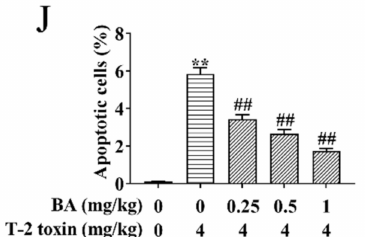
Figure 4. Effects of BA on spleen injury in T-2 toxin-exposed mice. Morphological changes in the spleen were examined using hematoxylin-eosin (H&E) staining. Notes: control group ( A ), T-2 toxin group ( B ), 0.25 mg/kg BA + T-2 toxin group ( C ), 0.5 mg/kg BA + T-2 toxin group ( D ), and 1 mg/kg BA + T-2 toxin group ( E ). Red arrow: macrophages. Yellow arrow: LYMs. Scale bar, 50 µ m. The ultrastructure of the spleen was observed using transmission electron microscopy (TEM). Notes: control group ( F ), T-2 toxin group ( G ), and 0.5 mg/kg BA + T-2 toxin group ( H ). Red arrow: mitochondria. Black arrow: nucleus. Green arrow: endoplasmic reticulum. Blue arrow: Golgi apparatus. Scale bar, 2 µ m. Splenocyte apoptosis was detected by terminal deoxynucleotidyl-transferase-mediated dUTP nick end labeling (TUNEL) assay ( I ). Scale bar, 50 µ m. Percentage of apoptotic cells ( J ). Data were presented as the mean ± SEM (10 mice per group). ** p < 0.01 vs. the control group. ## p < 0.01 vs. the T-2 toxin